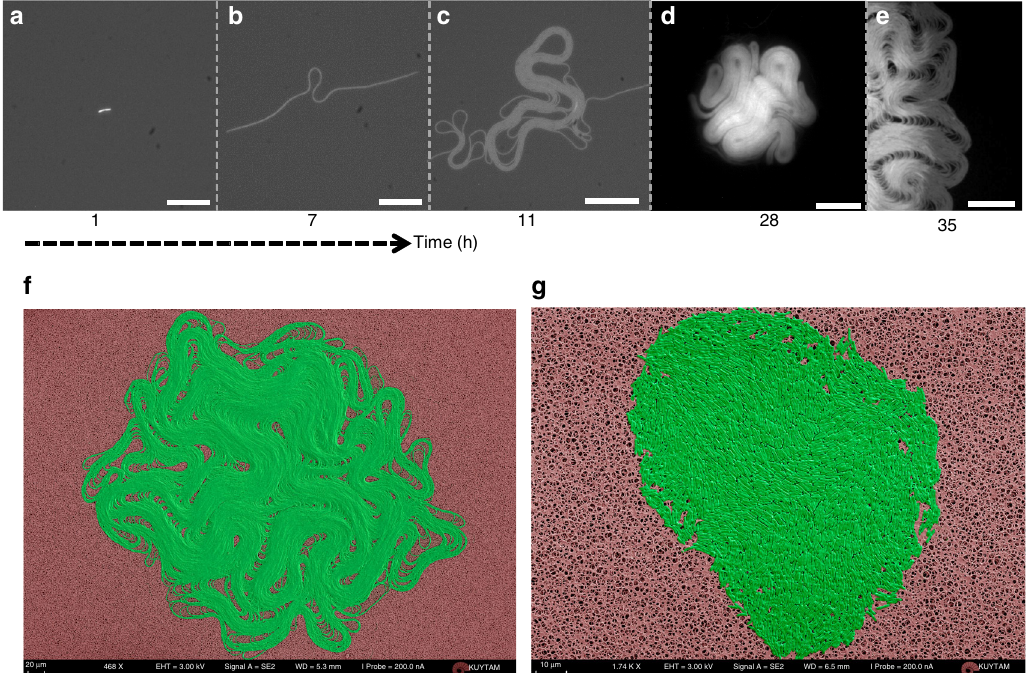
Fig. 1 Emergence of active nematics in a bacterial bio fi lm. Snapshots of a growing bio fi lm. a The bacterium initially elongates and forms a bacterial chain through proliferation ( t = 2.5 h). Scale bar, 30 μ m. b Due to local stress, the chain of attached bacteria buckles ( t = 7 h). Scale bar, 30 μ m. c Multilayered and circular structures appear at the region where the localized buckling takes place ( t = 11 h). Scale bar, 30 μ m. d The bio fi lm formation ( t = 28 h). Scale bar, 150 μ m. e Kink bands appear and separate different domains across the bio fi lm. Scale bar, 30 μ m. Scanning electron microscopy images of f the bio fi lm formed by GFP-labeled laboratory strain 168 (BAK47) and g the isolated bacterial colony formed by the non-chaining strain. All colonies were grown at T = 21